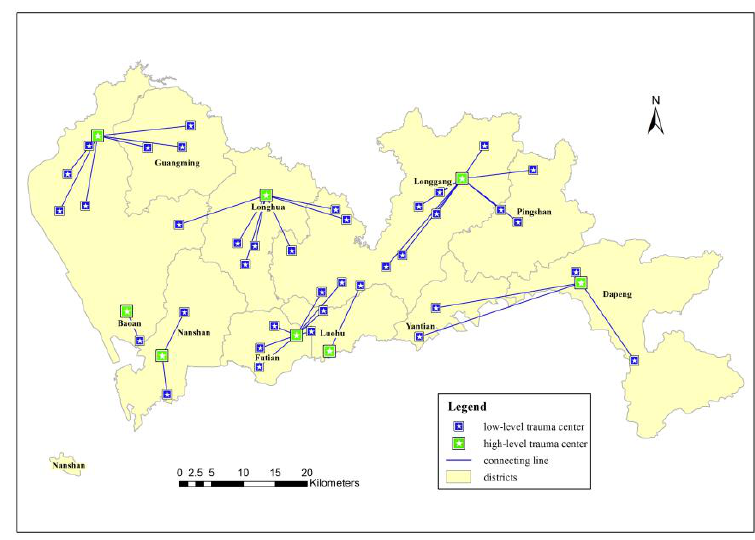
Figure 10. Emergency service allocations among high- and low-level trauma centers.